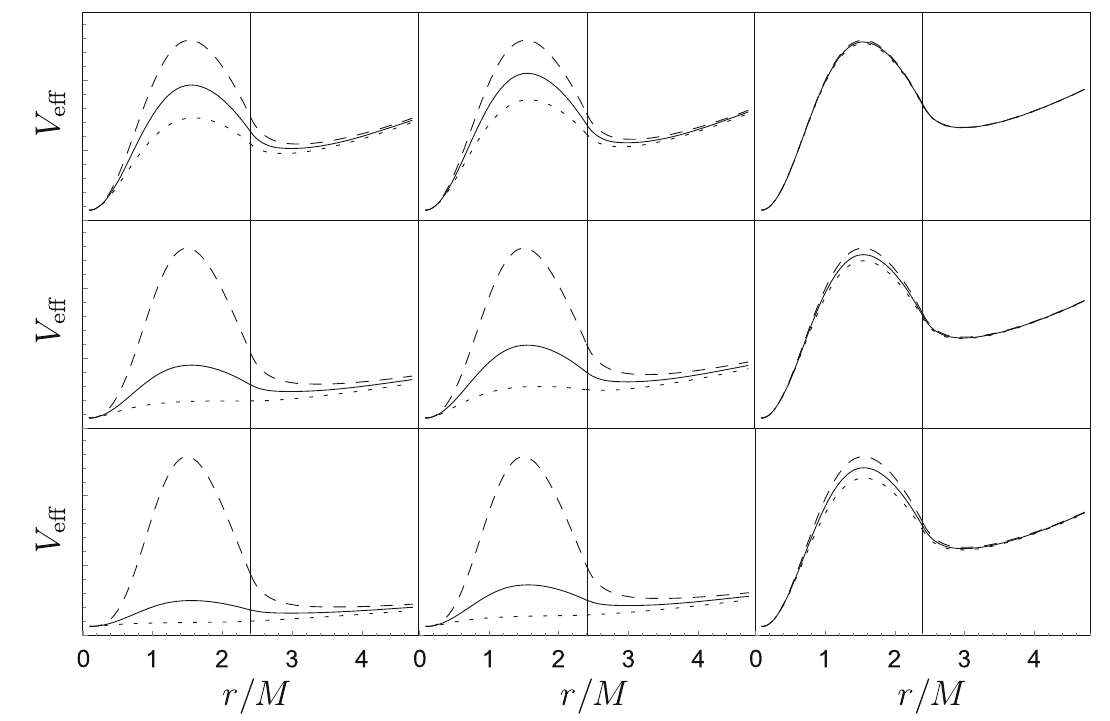
Fig. 7 Effective potentials for objects with compactness R / M = 2 . 4 for several values of j and θ . The solid lines are effective potentials for non-rotating configurations. The dotted and dashed lines denote effective potentials for co-rotating and counter-rotating null geodesics